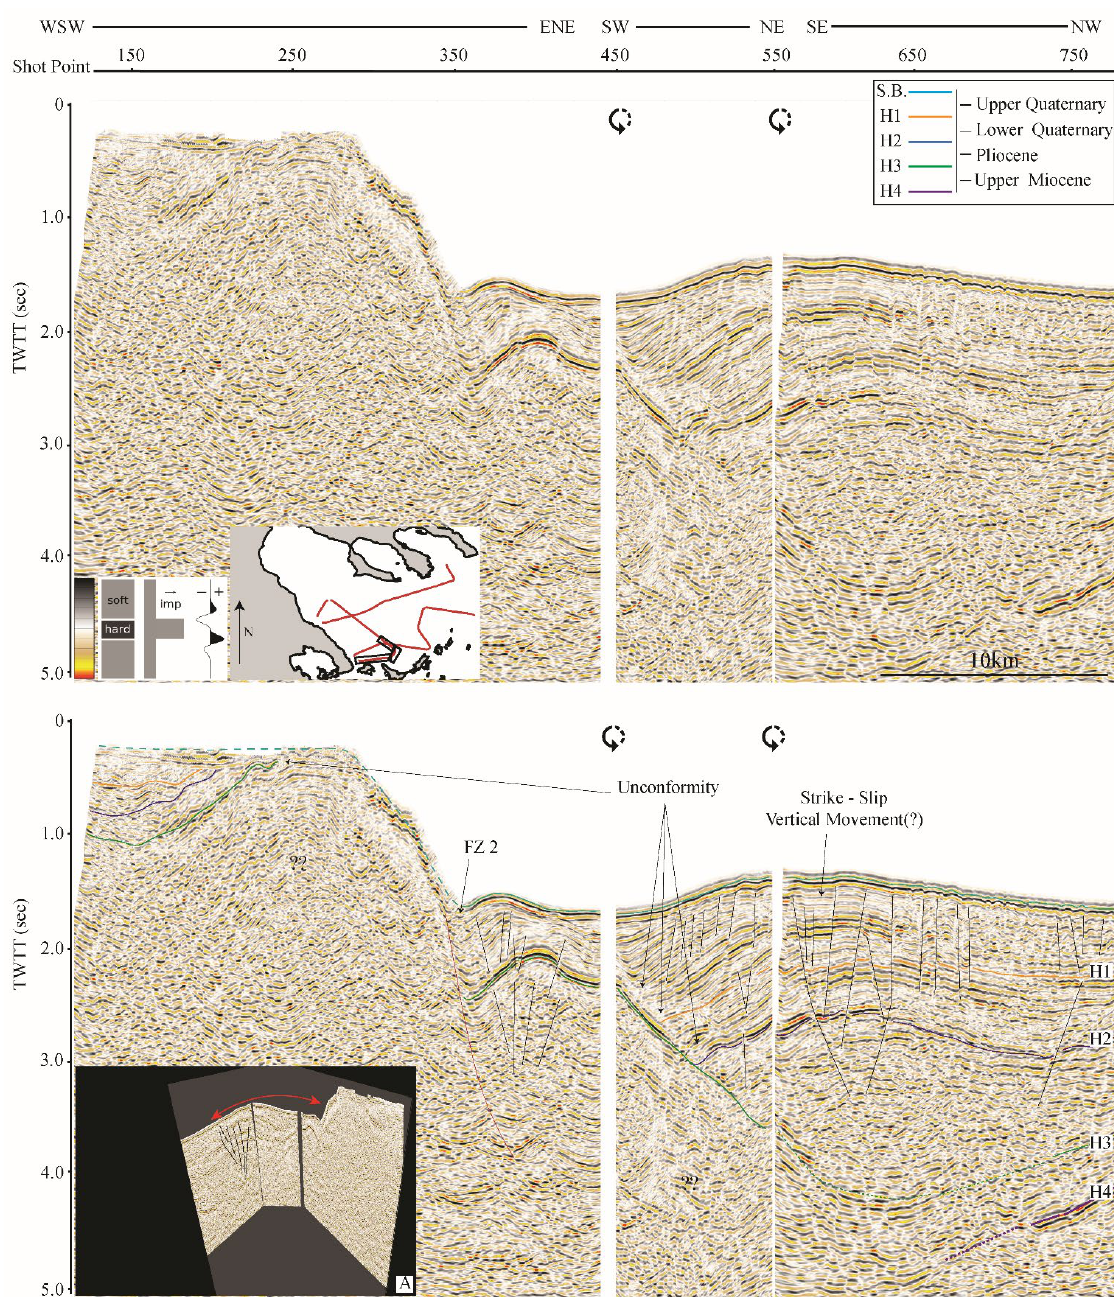
Figure 9. Seismic Lines HI, IM, and MN, Upper part: un-interpreted set of regional seismic profiles. Lower part: interpreted seismic sections with highlighted key horizons and the most prominent tectonic elements. ( A ) 3D perspective of the orientation of the three profiles. The main axis of the strike-slip deformation is tentatively placed parallel to the set of faults in line MN and the local uplift of H3 in line HI.